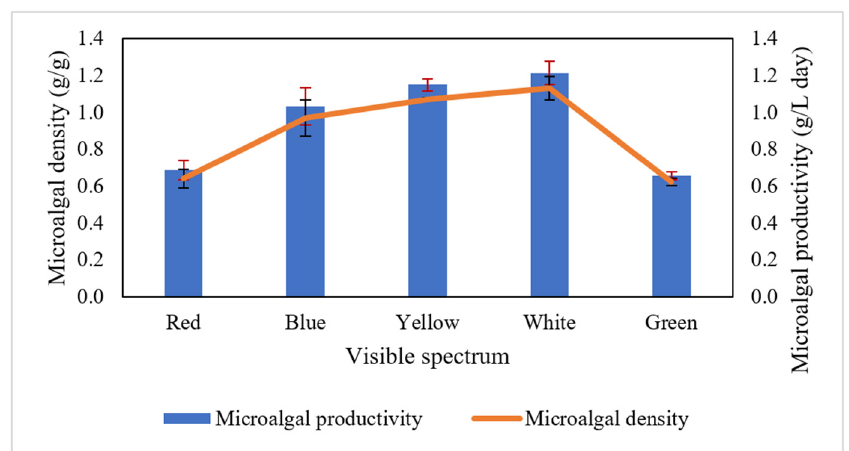
Figure 1. Productivity and density of attached microalgae on palm decanter cake at various visible spectra of irradiation.